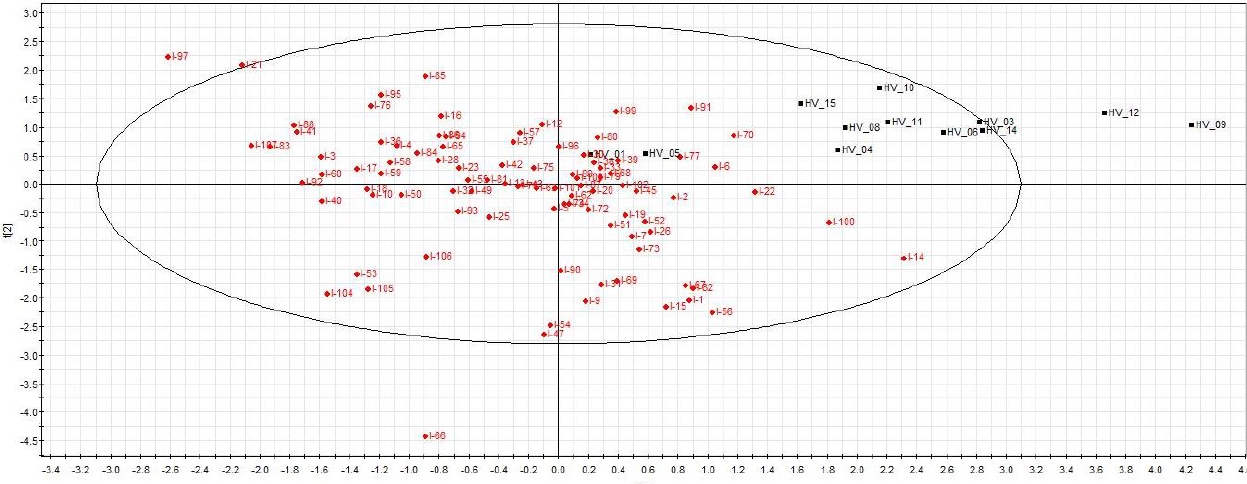
Figure 1. Scores plot (healthy volunteers versus ICU patients). The abbreviations HV represent healthy volunteers; the abbreviation I represent ICU patients. PLS-DA shows a separation between healthy volunteers and ICU patients (R 2 X = 0.27; R 2 Y = 0.62; Q 2 = 0.44).